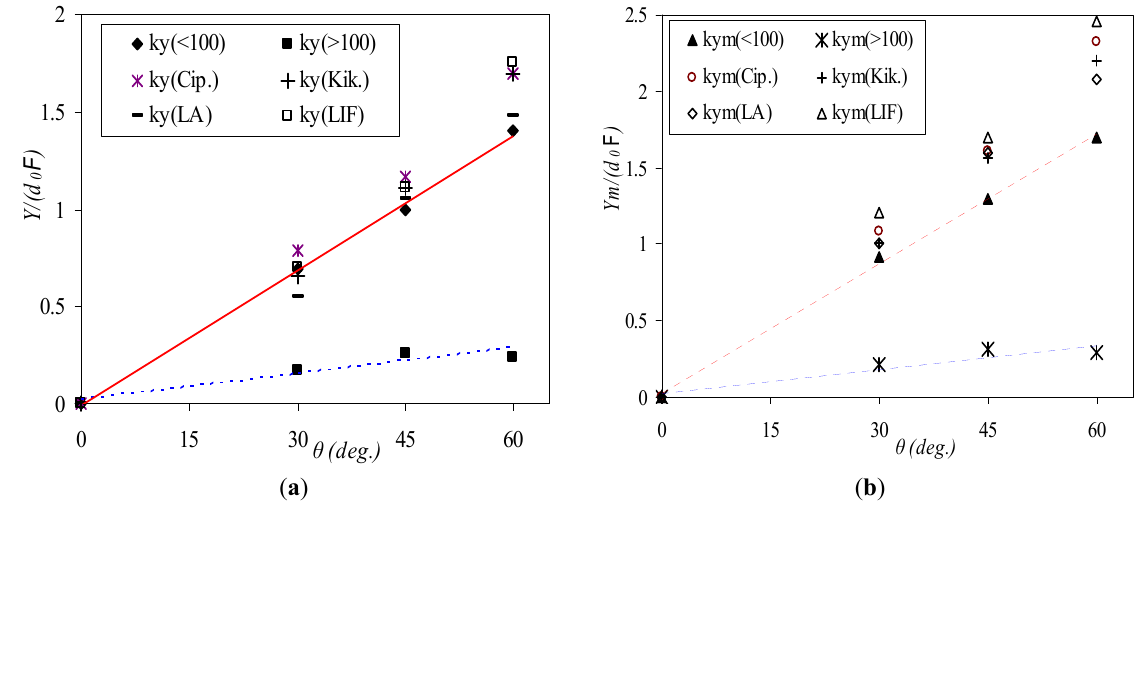
Figure 9. Slope coefficient for ( a ) maximum jet centerline level ( ky = Y/(d ( b ) maximum jet edge level ( k y Froude number below and above 100, together with results from previous